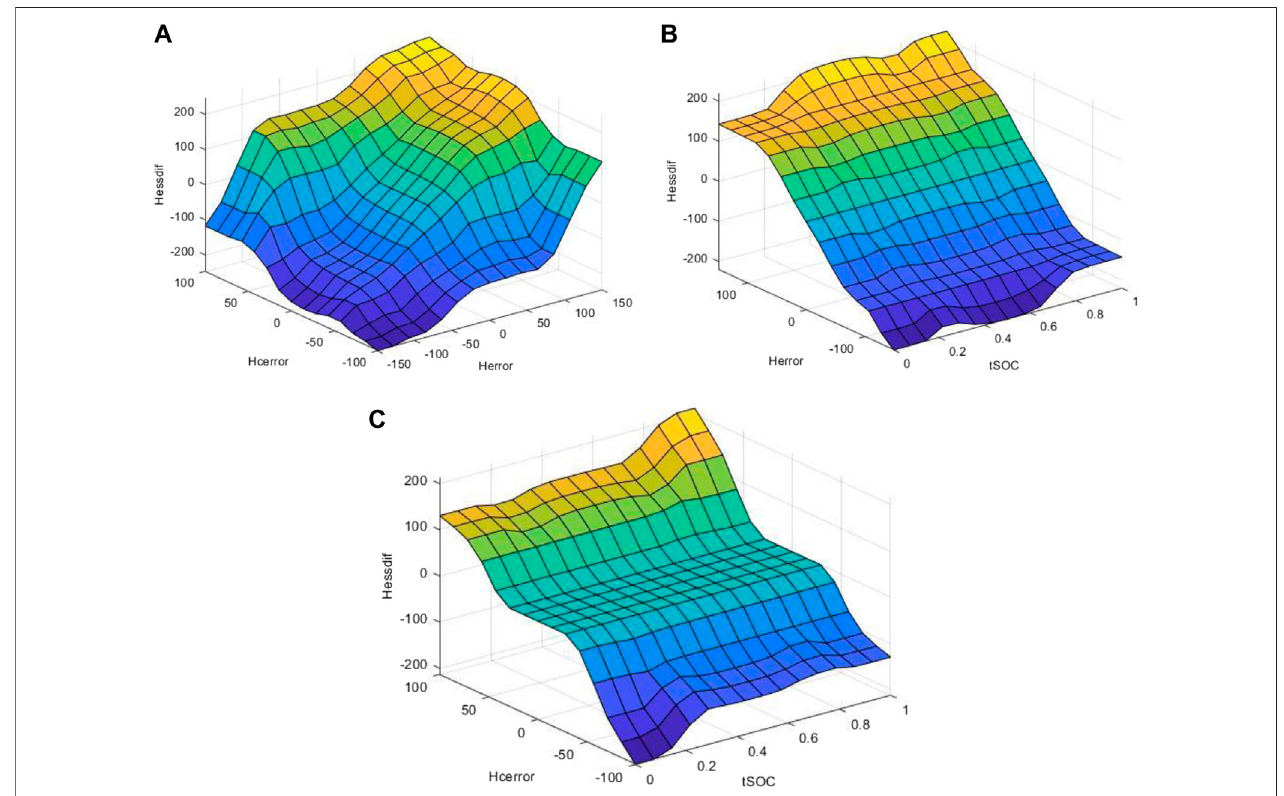
FIGURE 6 | Control surface of the ESS system